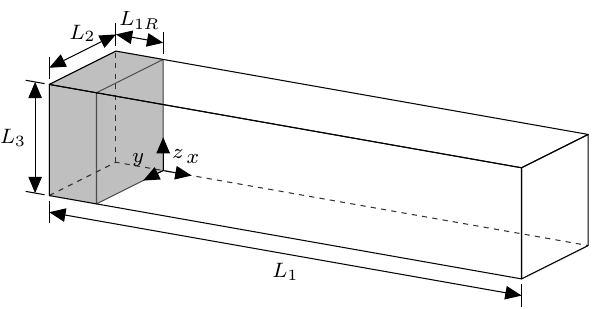
Figure 2. Lock-release simulation domain configuration. The grey region indicates the volume of non-zero sediment concentration at t = 0. The coordinate system defines the origin, x 0 , y 0 , z 0 u = ( 0 , 0 , 0 ) T at z = 0 and z = 2. All velocity boundary